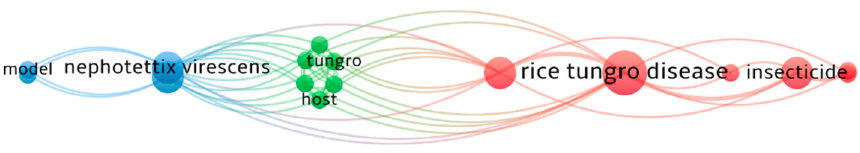
Figure 12. Research mapping on the mathematical model of the spread of tungro virus disease in rice plants.